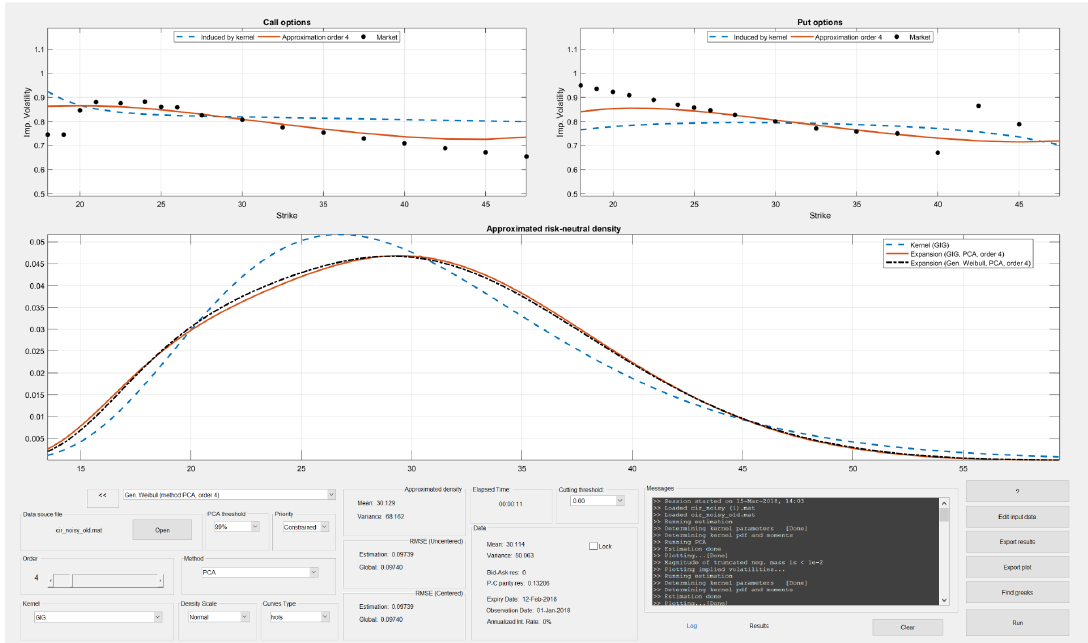
Figure 9. rndfittol output with the kernel density of the GIG, the fitted RNDs (with both GIG and GW) and the implied-volatility curve when observed option prices are contaminated by noise. The red line is the fitted RND obtained with the GIG kernel and the black line is the fitted RND obtained with GW kernel. In both cases, we consider PCA with expansion order n =